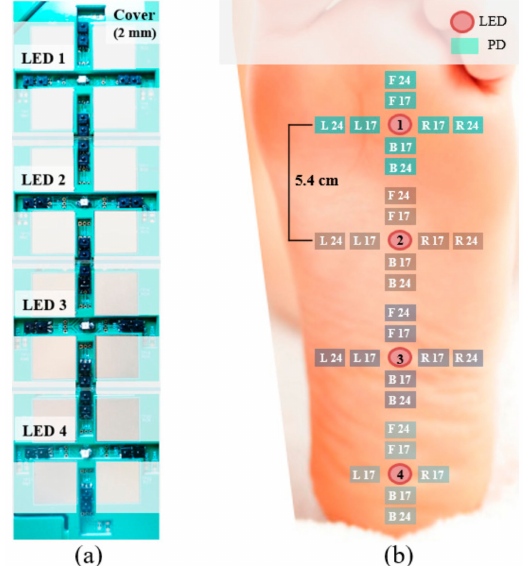
Figure 2. Foot PPG with a gap between the skin and embedded sensors. ( a ) Probes with a cover to form a gap between the skin and sensors. ( b ) Positions of four LEDs and 30